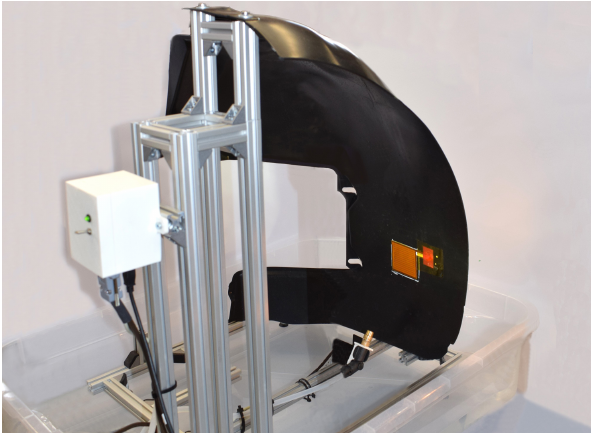
Figure 5. Test bench for the laboratory experiments, including a wheel arch liner, a high-pressure pump and a water nozzle.